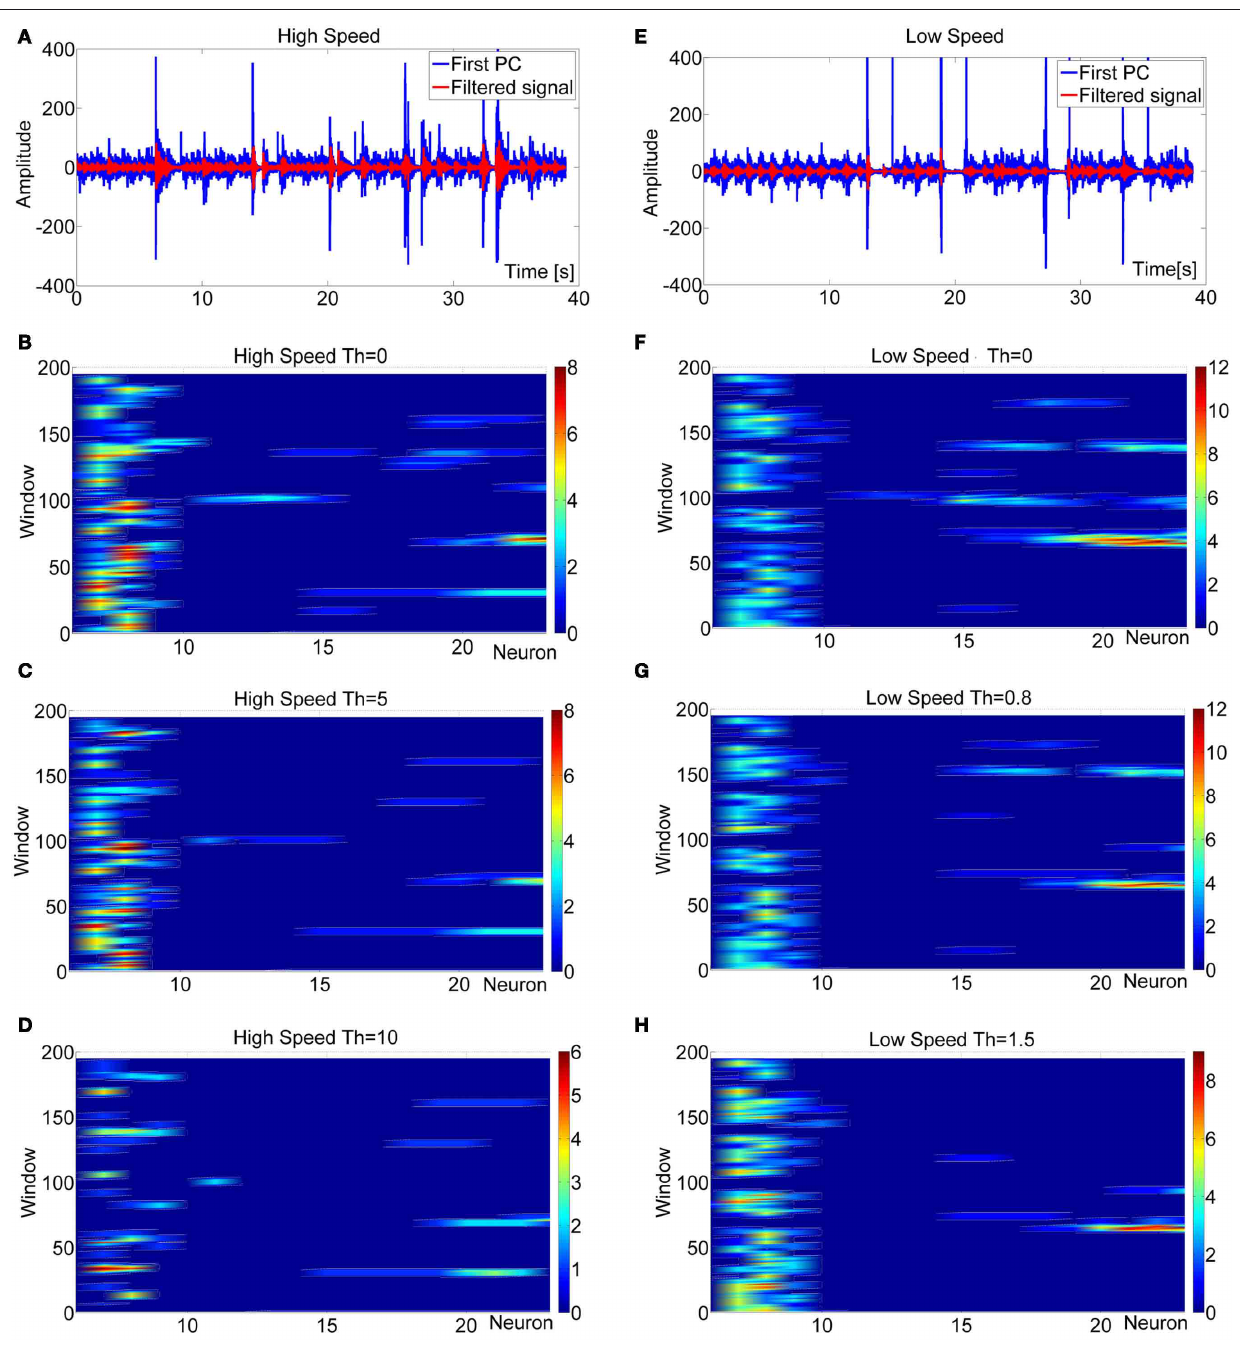
FIGURE 9 | Frequency maps obtained from data acquired during two experiments where the robot touched an obstacle several times and at different speeds: v high = 27cm/s, v low = 12cm/s. In the principal component (PC) of the acceleration data, the contact events could be identified as high-amplitude impulsive responses. For the high-speed experiment (A) the contact events occurred at t = 6s (window 30), t = 14s (window 70), t = 21s (window 105), t = 26s (window 130), t = 33s (window 165). For the low-speed experiment the contact events occurred at t = 13s (window 65), t = 19s (window 95), t = 27s (window 135), and t = 34s